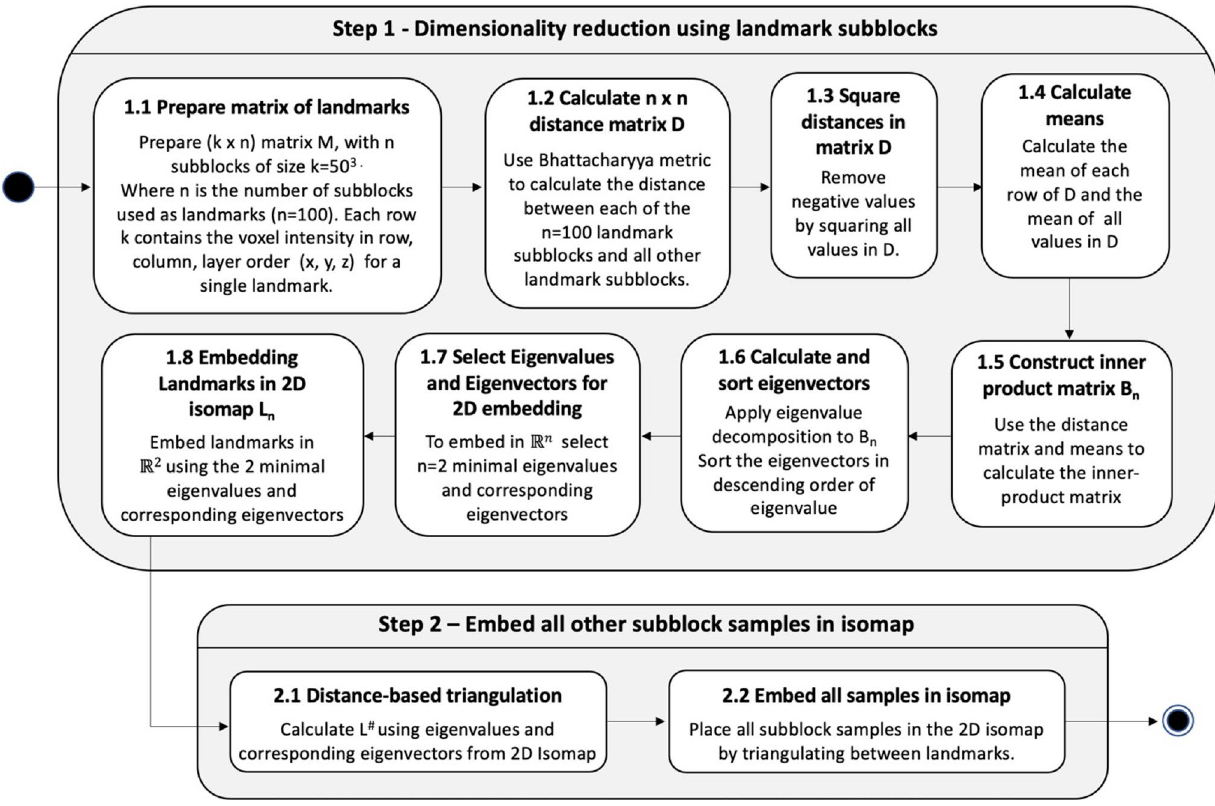
Fig. 6 Two-step algorithm for landmark multidimensional scaling (De Silva and Tenenbaum 2004)